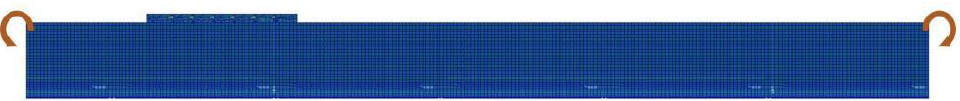
Figure 15. Schematic diagram of bending moment loading.